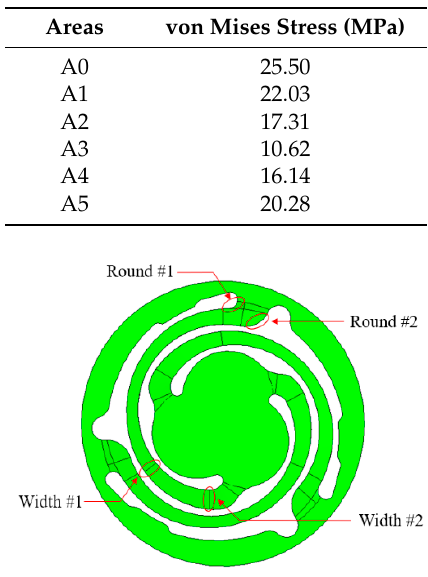
Table 2. von Mises stress at selected areas on prototype spring shape.